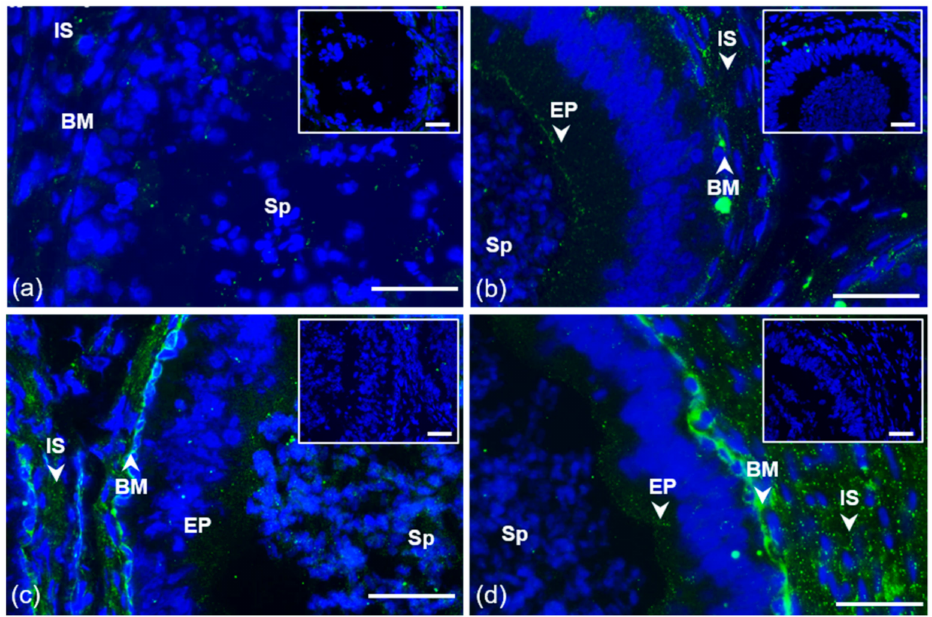
Figure 2. Localization of GPER1 in bull reproductive tissues. Cryo-sections of bull testes ( a ); caput ( b ), corpus ( c ), and cauda epididymis ( d ). Tissues were treated with antibody K-19 (green) or rabbit IgG isotype control. Sp, spermatozoa; IS, interstitial tissue; BM, basal membrane; EP, epithelial cells. Nuclear DNA was stained by DAPI (blue). Isotype controls are shown in the top right corner of the figures. Arrows show a positive reaction in tissues. Scale bar represents 50 µ m ( a – d